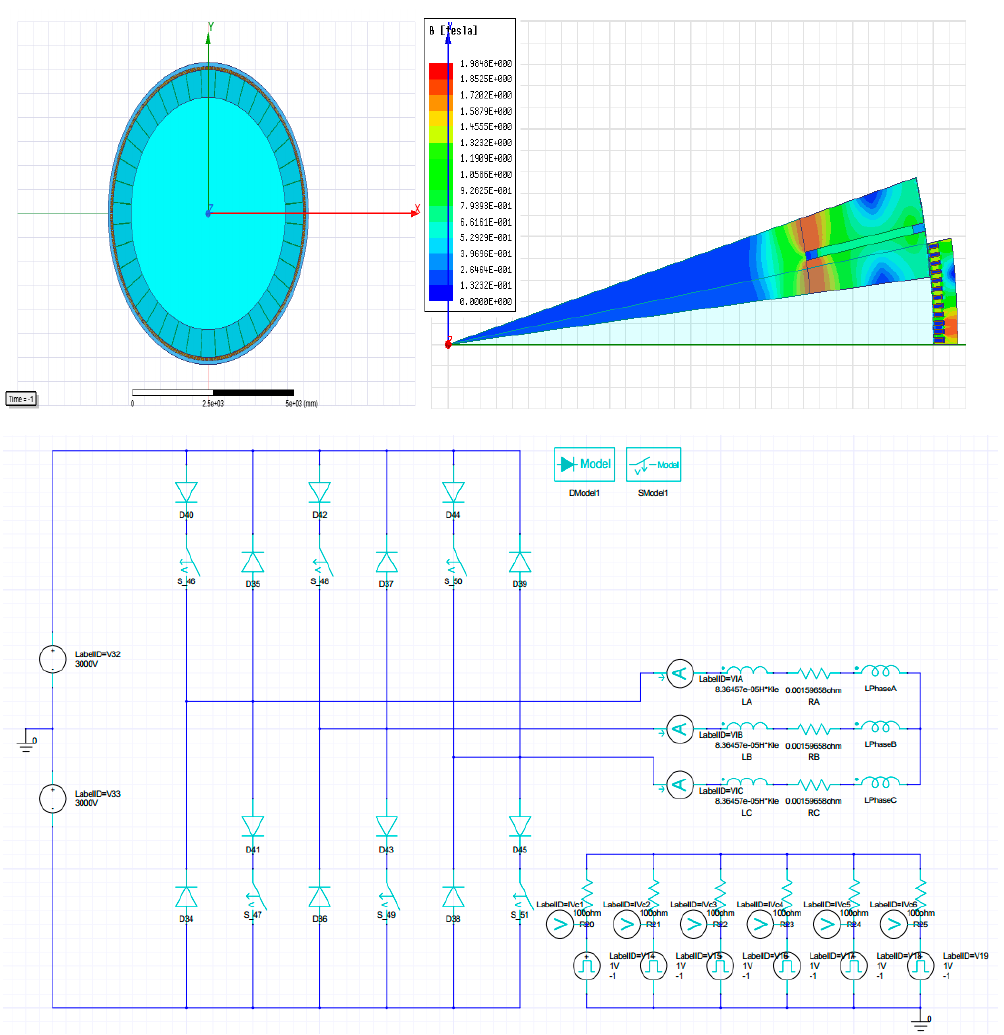
Figure 6. Modeling of the BLDC motor with tangential magnets in a Maxwell 2D Design.